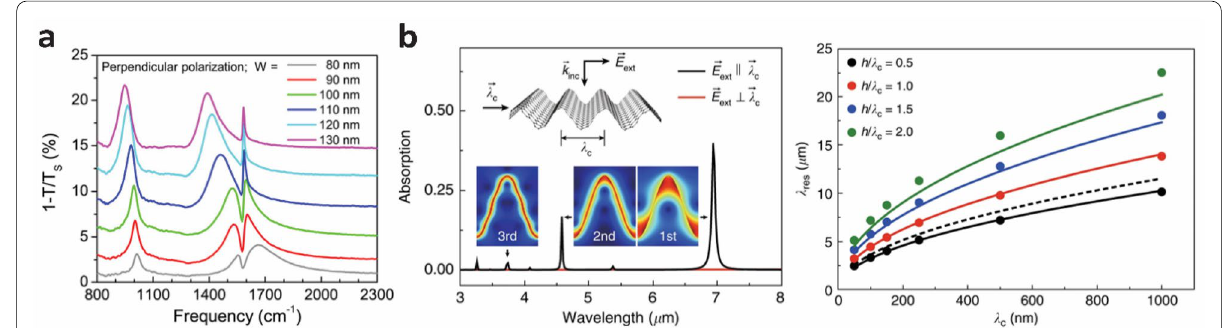
Fig. 3 Tuning graphene plasmons by modulating widths of graphene ribbons ( a ) and introducing out-of-plane deformations ( b ). a Extinction spectra of bilayer graphene ribbon. The plasmon-phonon coupling is shown by the spectral dip near 1580 cm − 1 which depends on the ribbon width. Reprinted with permission from [46]. Copyright 2014 American Chemical Society. b Optical absorption spectra of a crumpled graphene structure for a corrugation pitch ( (cid:31) c ) of 250 nm and aspect ratio ( h / (cid:31) c , h refers to the height of the corrugation) of 1 (left). direction of the excitation. Different plasmon resonance modes are shown in the inset. Right panel shows the plasmon resonance wavelength ( (cid:31) res ) dependence on the (cid:31) c and aspect ratio. The solid curves represent (cid:31) res calculated from the LC-circuit model and dashed curve represent (cid:31) res estimated from the conventional analytical model. Reprinted under the terms of the Creative Commons License from [49]. Copyright 2018 The Authors. Published by Springer